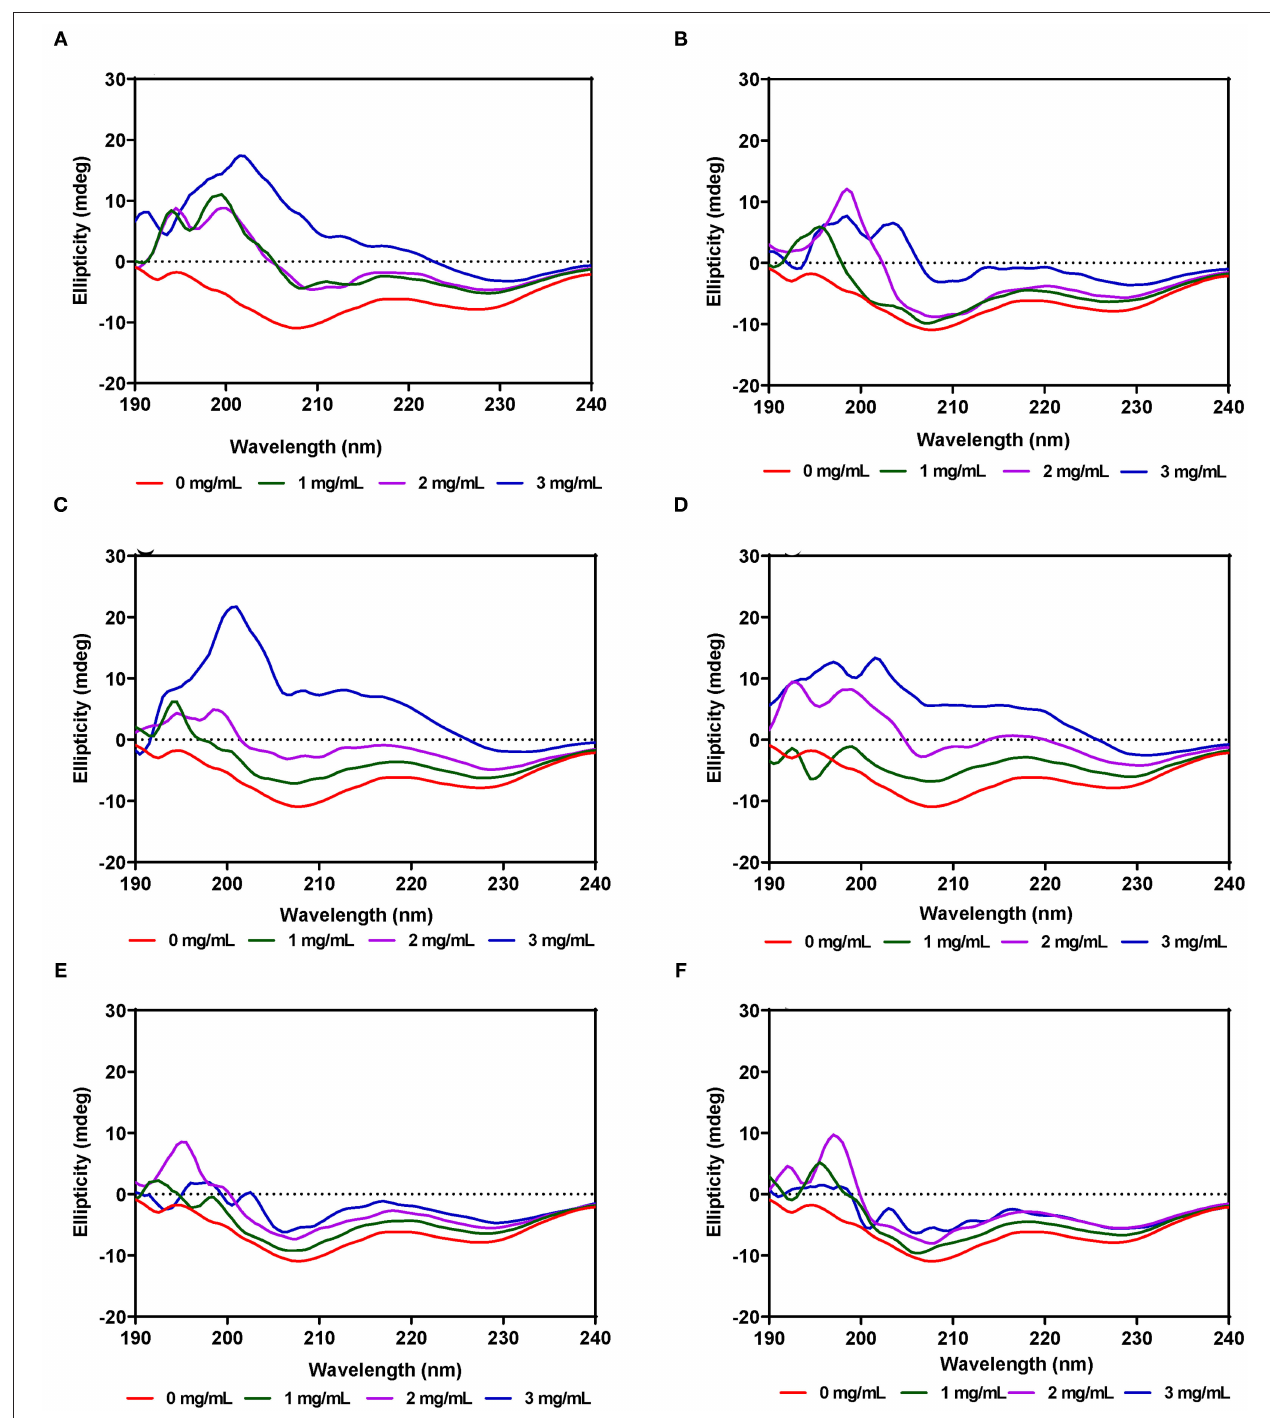
FIGURE 5 | Far-UV CD of α -amylase in the presence of varied concentrations of leaf extracts from: (A) AV-20-T1, (B) AV-20-T2; (C) SM-20-T1, (D) SM-20-T2, (E) TO-20-T1, and (F) TO-20-T2. Plants were produced with nitrogen fertilizer (20 kg N/ha), which was applied at (T1) or after (T2) planting.